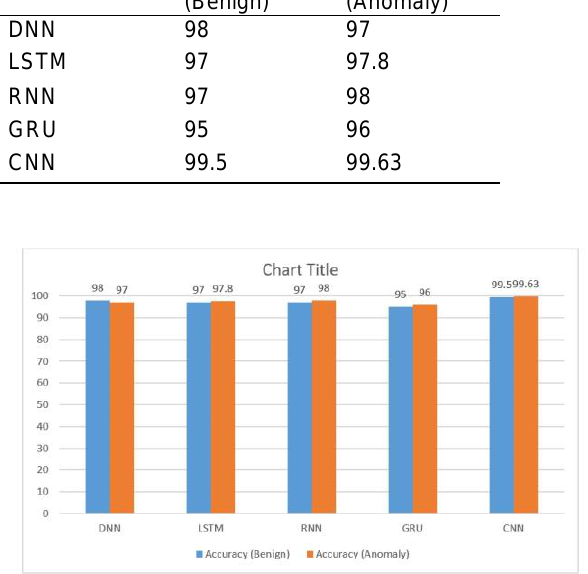
Figure 9. Benign and Anomaly Accuracy